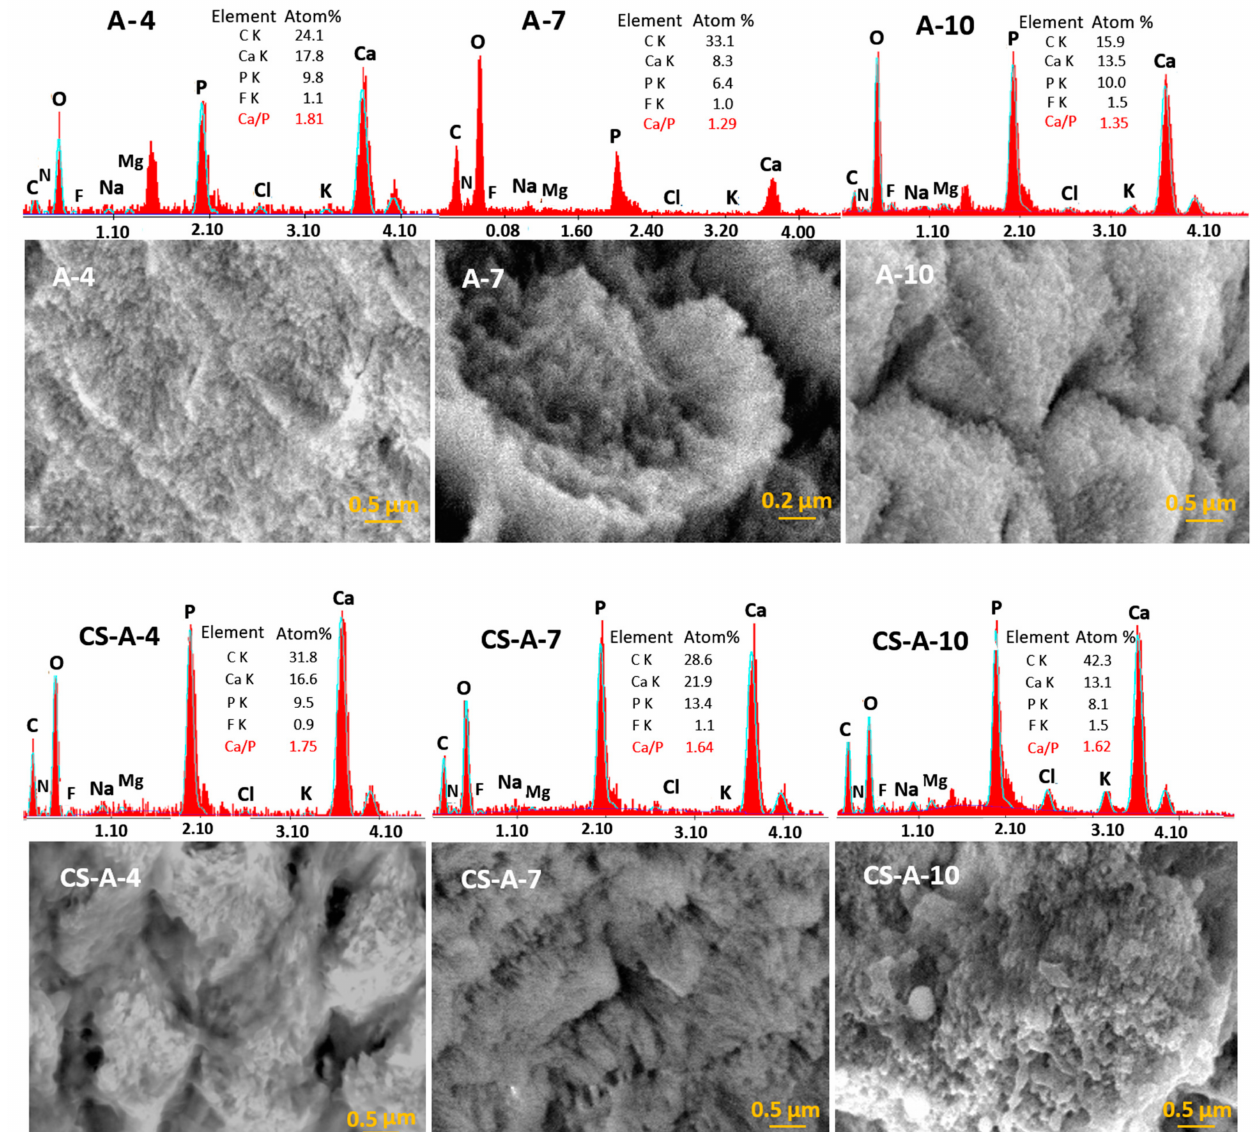
Figure 6. SEM-EDX data for remineralized samples under A-hydrogel (A-series) and CS-A-hydrogel (CS-A-series),